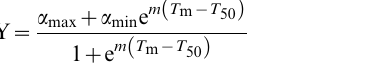
Figure S3 The thermal transition of apoSOD1 F64A